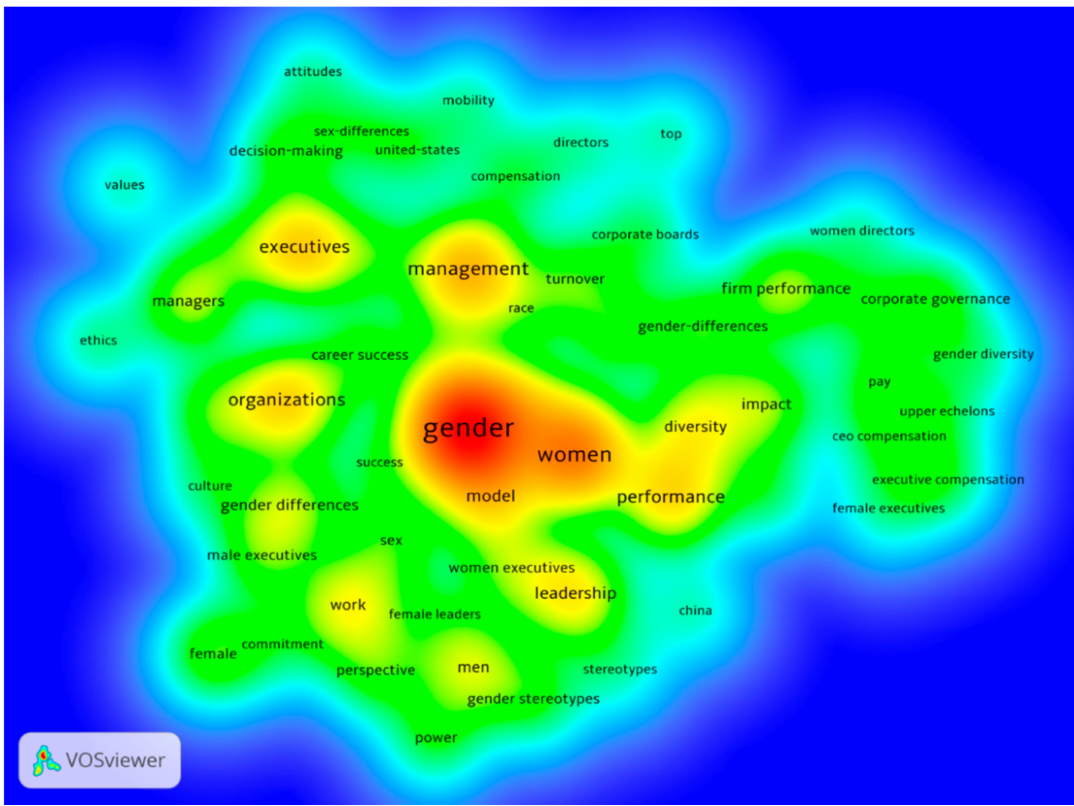
Figure 5. Bibliometric density map (co-words). Source: Prepared by the authors.